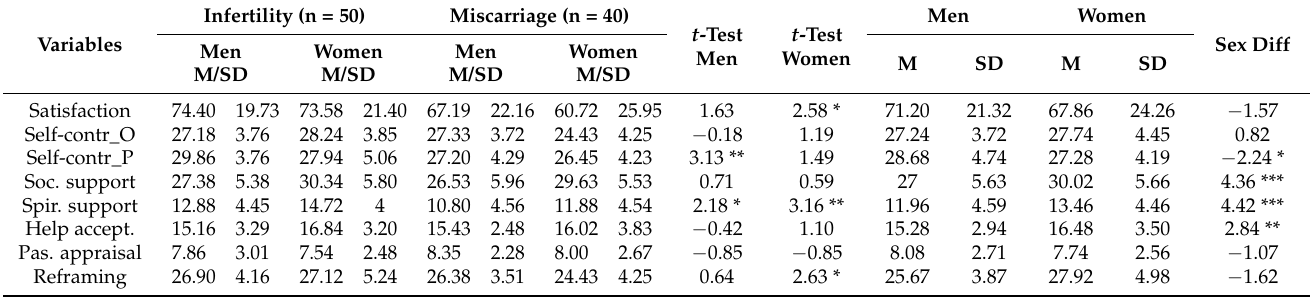
Table 1. Descriptive statistics, genders, and differences between the infertility and miscarriage groups.